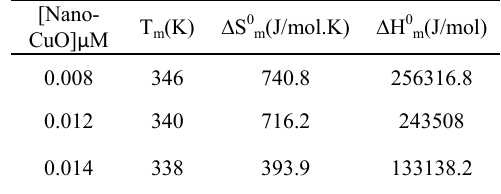
Table 1 . Thermodynamic data of proteinase K at various nano-CuO concentrations at